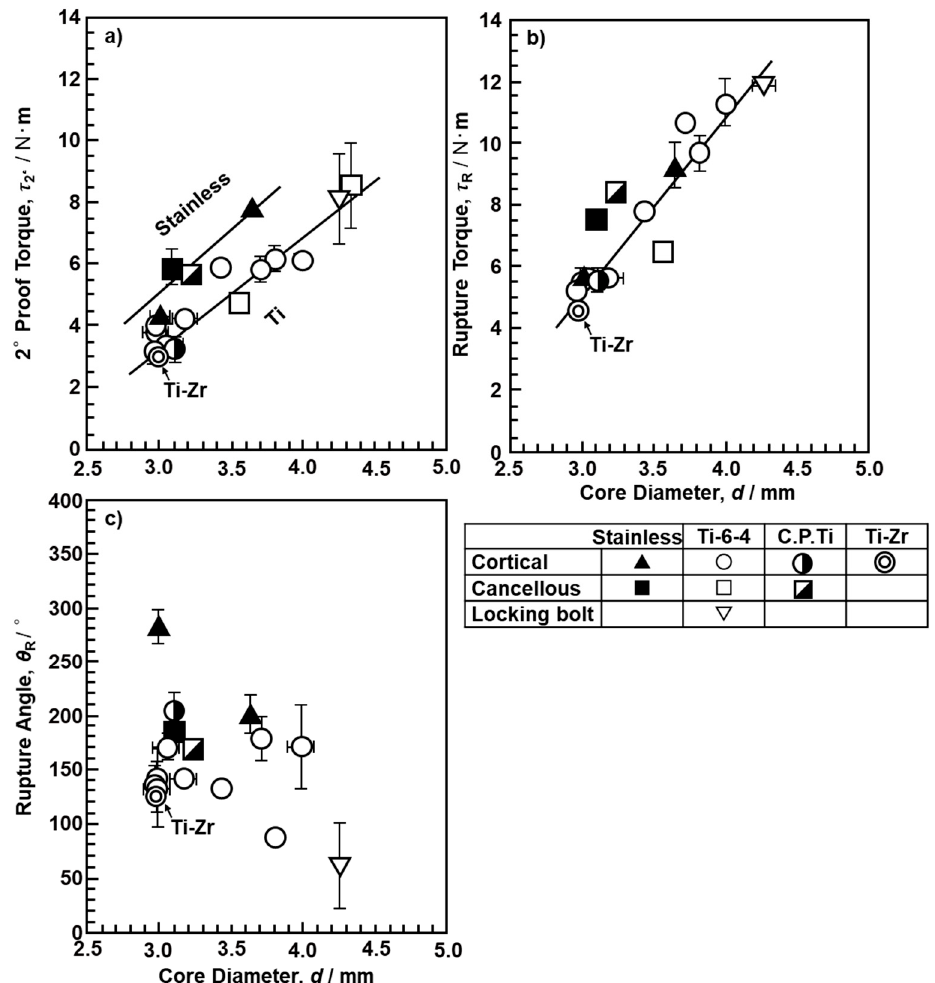
Figure5. E ff ectsofcorediameterofscrewon( a )2 ◦ prooftorque, ( b )rupturetorque, and( c Figure 5. Effects of core diameter of screw on ( a ) 2° proof torque, ( b ) rupture torque, and ( c ) rupture angle.